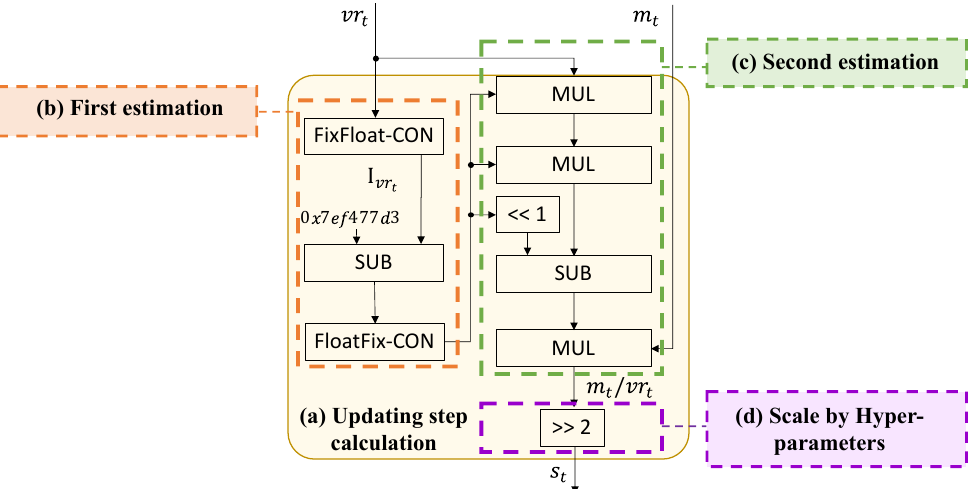
Figure 5. Hardware design for the updating step calculation module of F-ADAM. Subgraph ( a ) is the overall structure of the updating step calculation module. Subgraph ( b ) is the first estimation of 1/ vr t . Subgraph ( c ) is the second estimation of 1/ vr t and the calculation of ( 1/ vr t ) ∗ m t . Subgraph ( d ) is the optimized calculation of scaling by